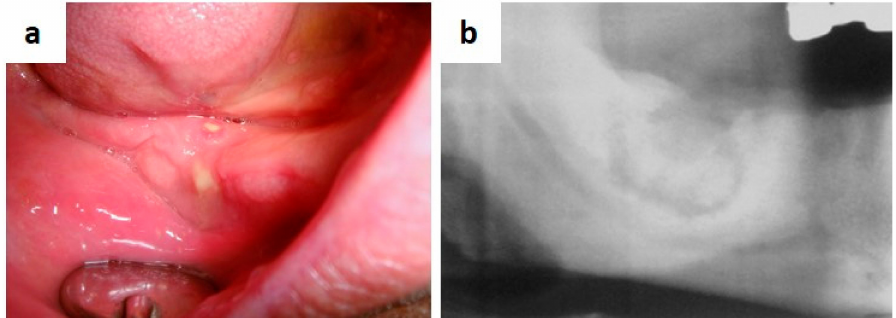
Figure 15. ( a , b ) Post-extraction site with delayed healing, swelling, pus discharge and bone exposure ( a ) in patient taking Zoledronic acid (e.v.) as in systemic therapy for multiple myeloma; lesion appears as a radiolucency with ill-defined borders encompassing a bone sequestrum ( b